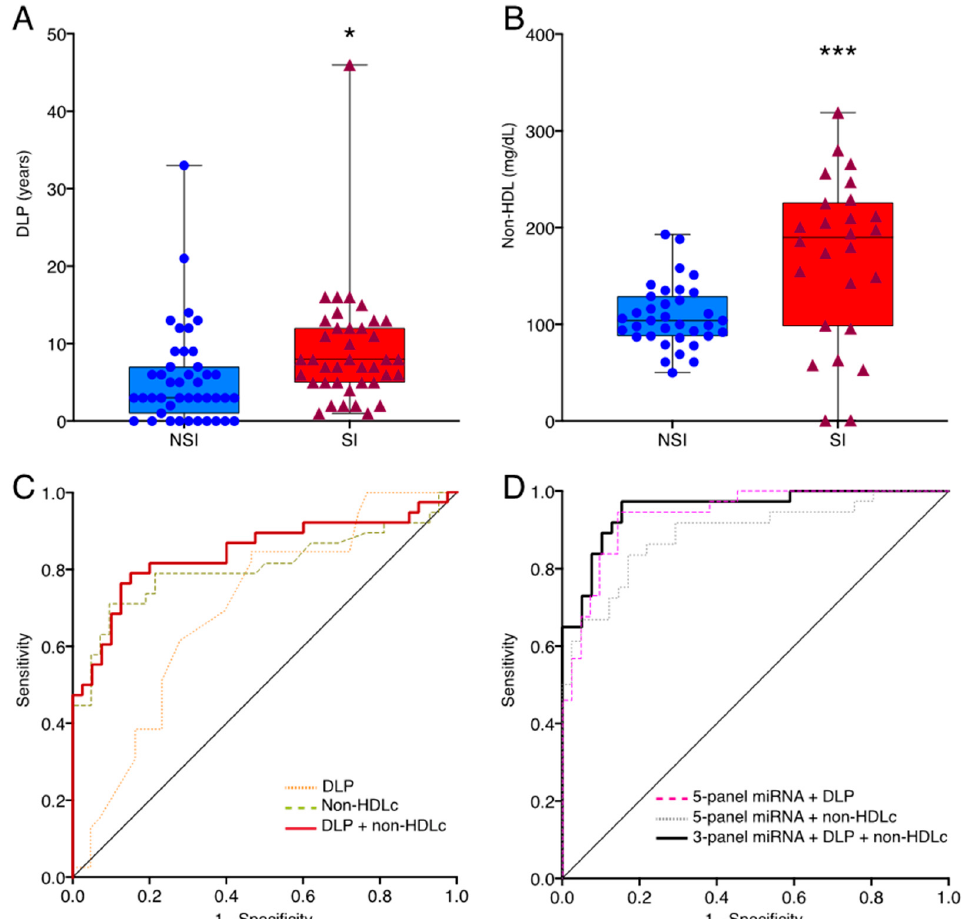
Figure 4. ROC curves for evaluating the predictive performance of clinical factors with differentially expressed miRNAs. ( A ) Box plot of DLP in NSI ( n = 45) and SI ( n = 39) subjects. ( B ) Box plot of non-HDLc levels in NSI ( n = 45) and SI ( n = 39) subjects. ( C ) ROC curves for each clinical parameter, DLP and non-HDLc, and for the association of DLP plus non-HDLc. ( D ) The ROC curve of the combined value of the 3-miRNA panel (let-7f-5p, miR-376a-3p and miR-376c-3p), DLP and non-HDLc plasmatic concentration. DLP: years of dyslipidemia SI: statin intolerant; NSI: non-statin intolerant; non-HDLc: non-high-density lipoprotein cholesterol. *p < 0.05; *** p < 0.005.